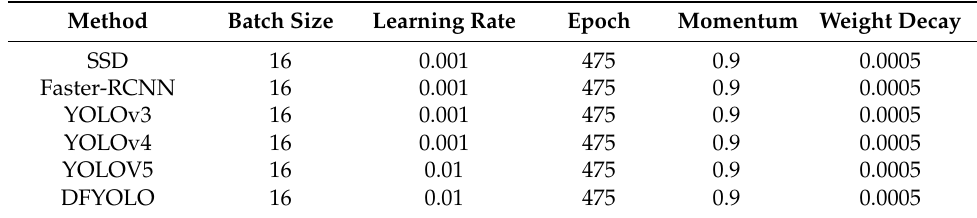
Table 3. Parameter settings for different detection networks.